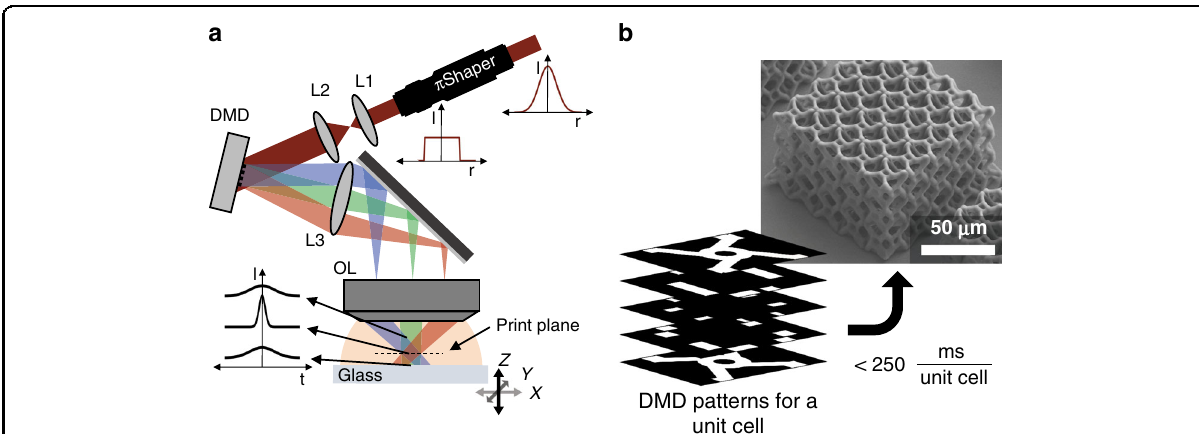
Fig. 1 Continuous, layer-by-layer projection two-photon lithography system. a Schematic of spatiotemporal printing system, omitting mirrors and observational imaging system. A Gaussian spatial laser pro fi le was transformed to a fl attop intensity via π Shaper. Lens pair L1 ( f = 100 mm) and L2 ( f = 150 mm) expanded the beam diameter to fi ll the DMD active area. Lens L3 ( f = 300 mm) collected the diffracted light, and an objective lens (OL) reformed the DMD pattern at the print plane inside a liquid photoresist. A glass substrate was translated along 3 axes during fabrication. Laser pulse intensity was highest at the print plane and dramatically reduced both before and after the print plane as a result of temporal focusing. b Example of select DMD patterns displayed during 3D fabrication of a single 3D unit cell and the resulting 5 × 5 × 3 unit lattice